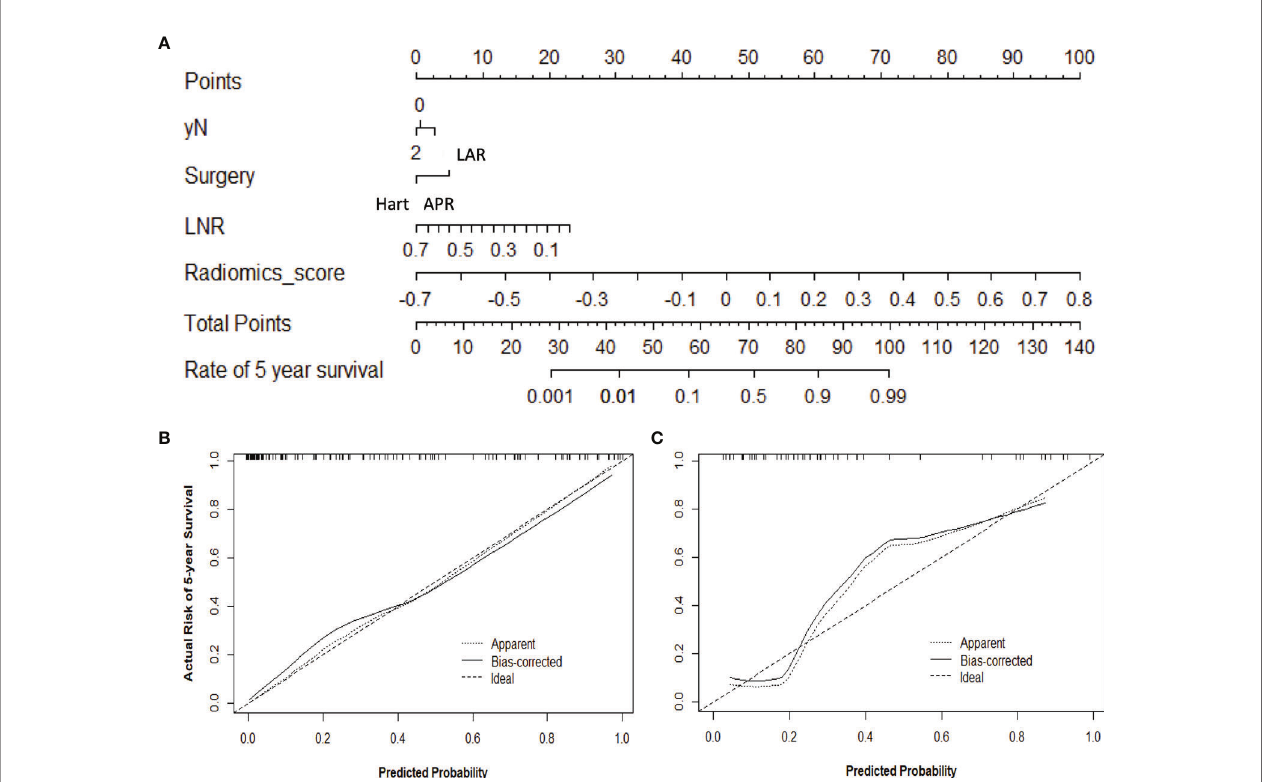
FIGURE 7 | Use of the constructed nomogram to estimate 5-year OS probability, along with the assessment of the model calibration, (A) nomogram with combined radiomics and non-radiomics clinical information, and calibration curves for the nomogram in the (B) training and (C) validation data sets. The y-axis represents the actual rate, and the x-axis represents the predicted probability of 5-year OS, with the diagonal line representing a perfect prediction. The solid line represents the performance of the radiomics model, of which a closer fi t means better prediction.